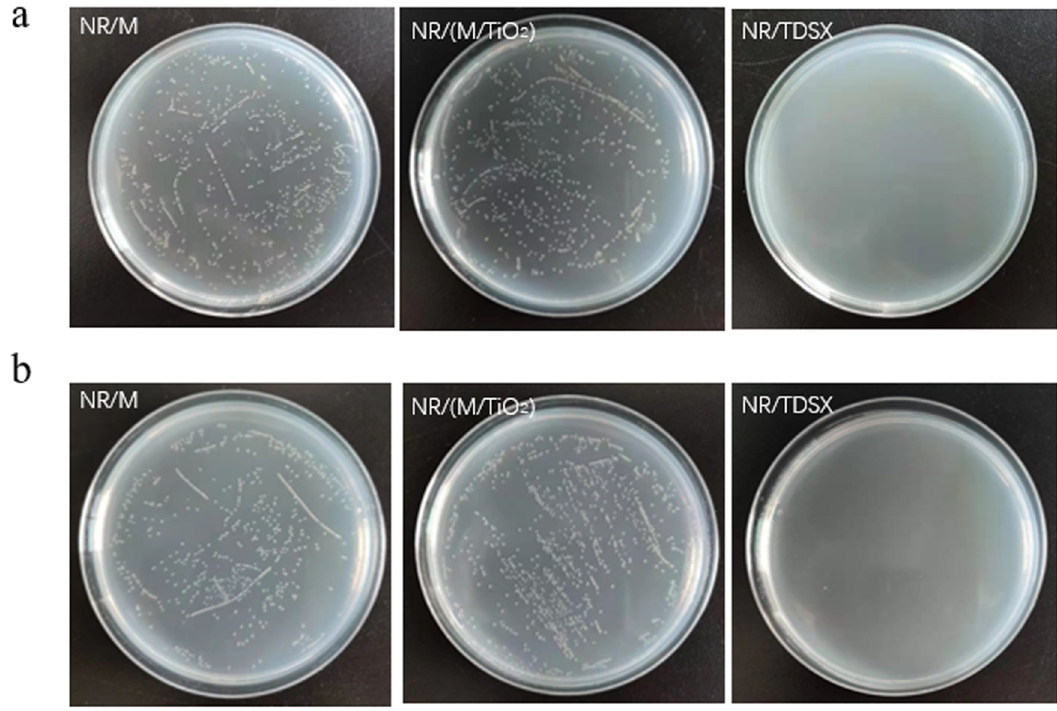
Figure 6: Antibacterial properties of NR composites against Escherichia coli ( a ) and Staphylococcus aureus ( b ) .